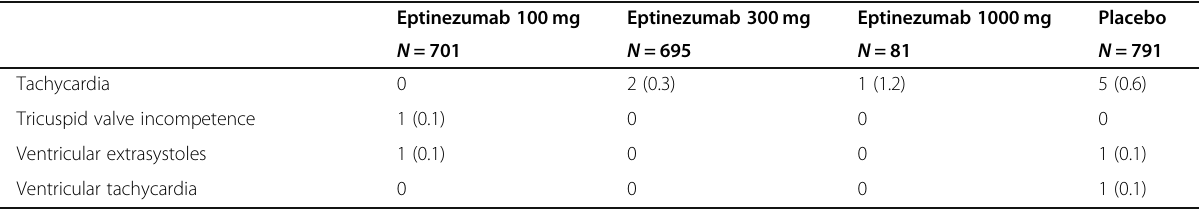
Table 2 Baseline Demographics and Characteristics (Continued)